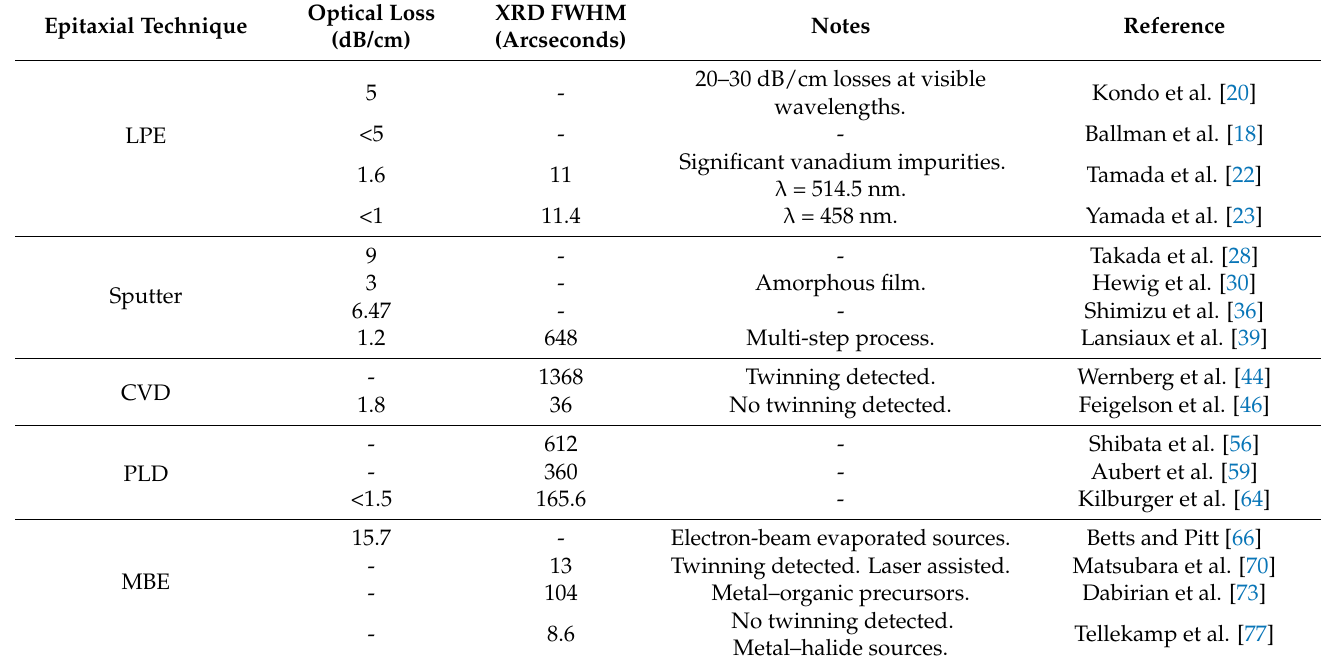
Table 1. Comparison of optical loss and X-ray diffraction rocking curve full width at half maximum (FWHM) metrics for different epitaxial techniques as reported. Unless specified otherwise, optical losses are measured in the TE 0 mode at wavelength λ = 632.8